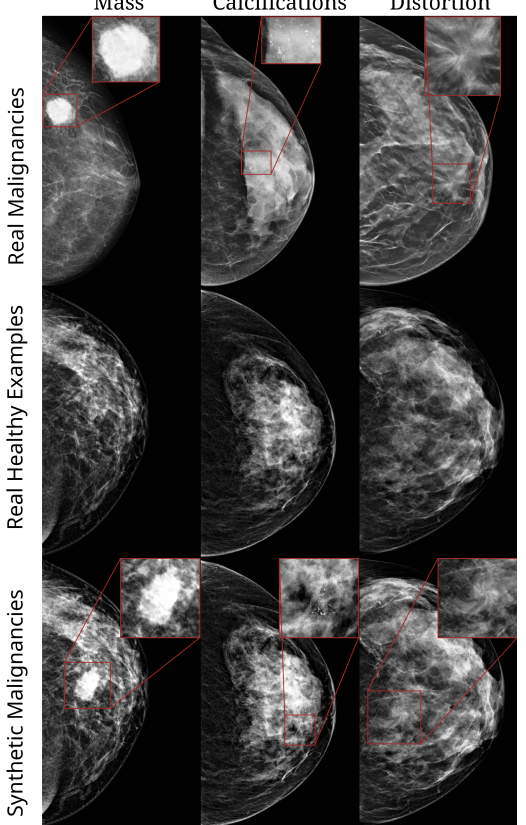
Figure 1. Examples of images from HMI dataset. Top row : real malignant examples of a mass, cluster of calcifications, and architectural distortion, respectively. Second row : healthy/normal breasts. Third row : healthy breasts with synthetic lesions (mass, calcifications, and distortion,